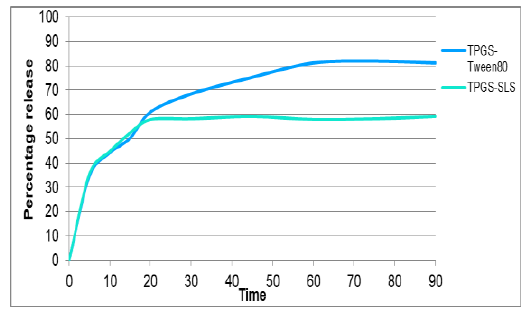
Figure 5. Effect of co-stabilizer to TPGS on release profile in 0.1N HCl and 37  C